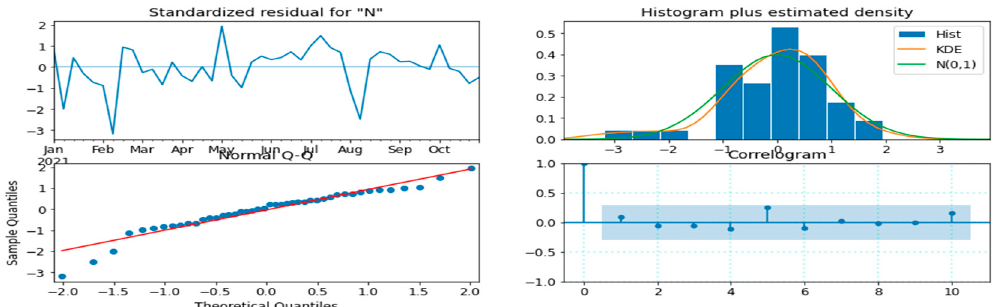
Figure 16. Daily time series residual plot.